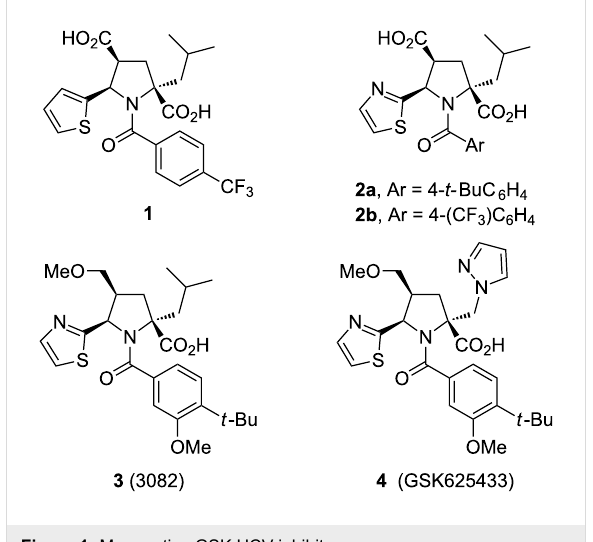
Figure 1: More active GSK HCV